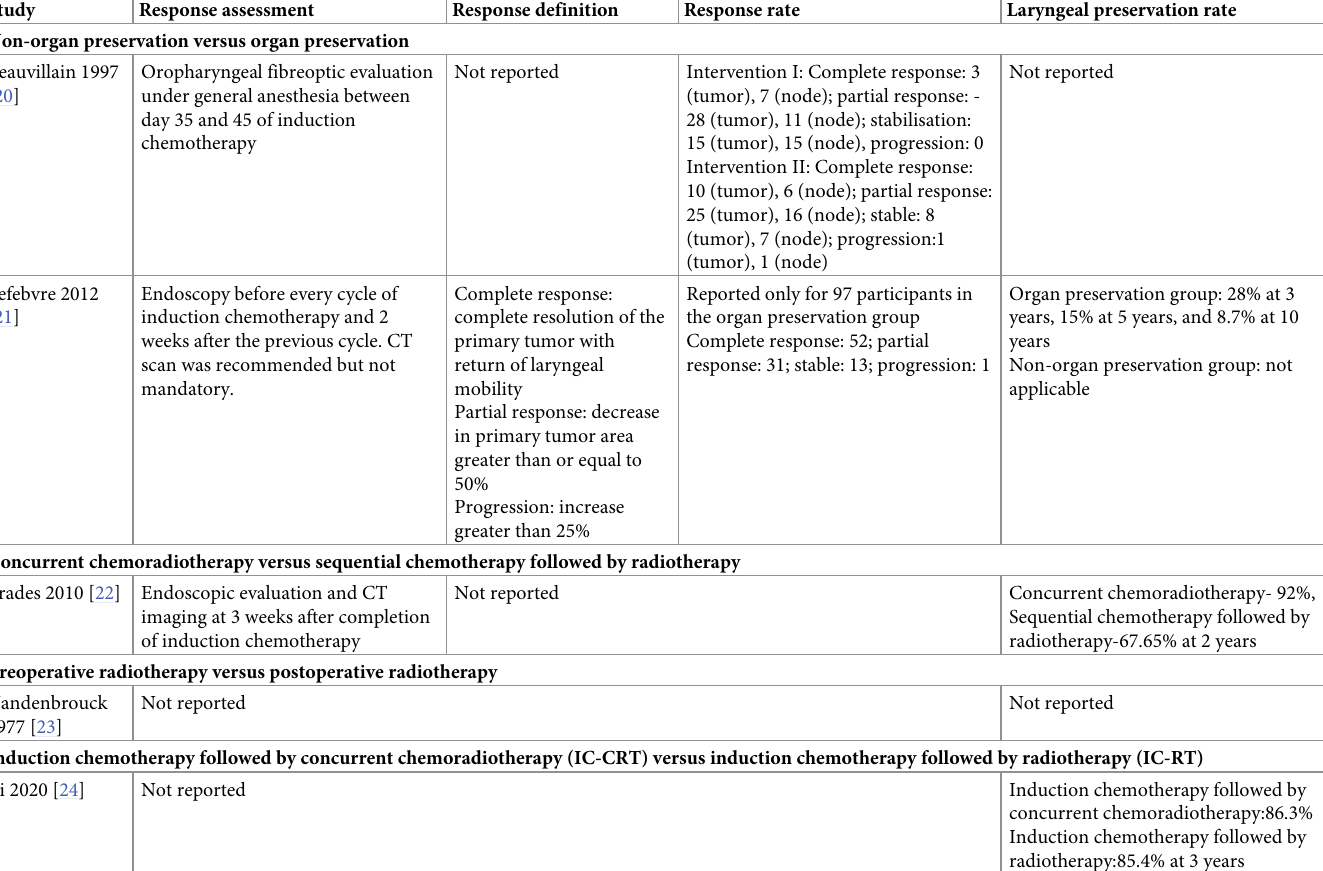
Table 3. Response assessment following induction chemotherapy and larynx preservation